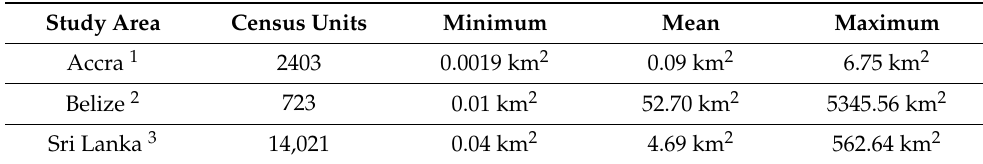
Table 2. Study area census unit counts and spatial area